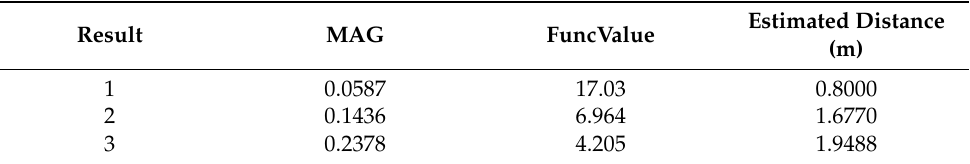
Figure 12. The near-field imaging results of real measurement imaging experiment. ( a ) Result 1; ( b ) result 2; ( c ) result 3. Table 5. MAG of near-field imaging results for different estimated distances in real measurement imaging experiment.